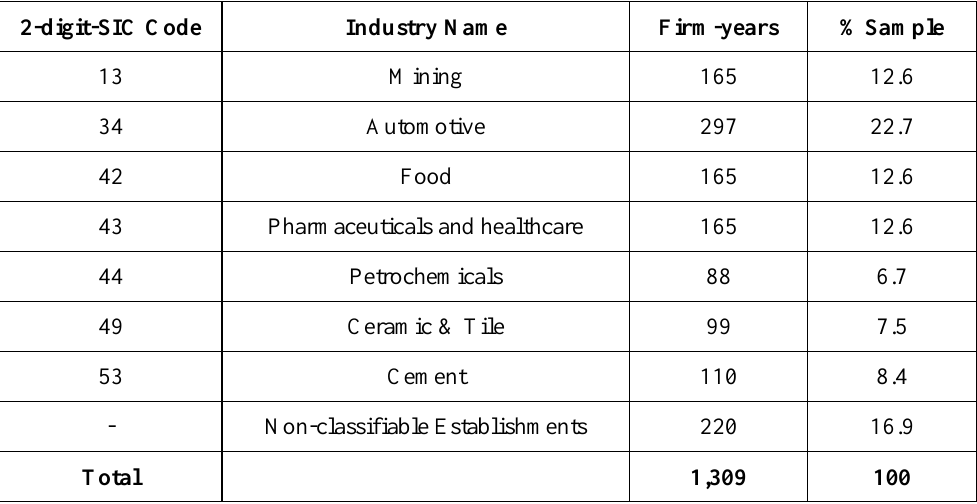
Table 1. Sample distribution based on